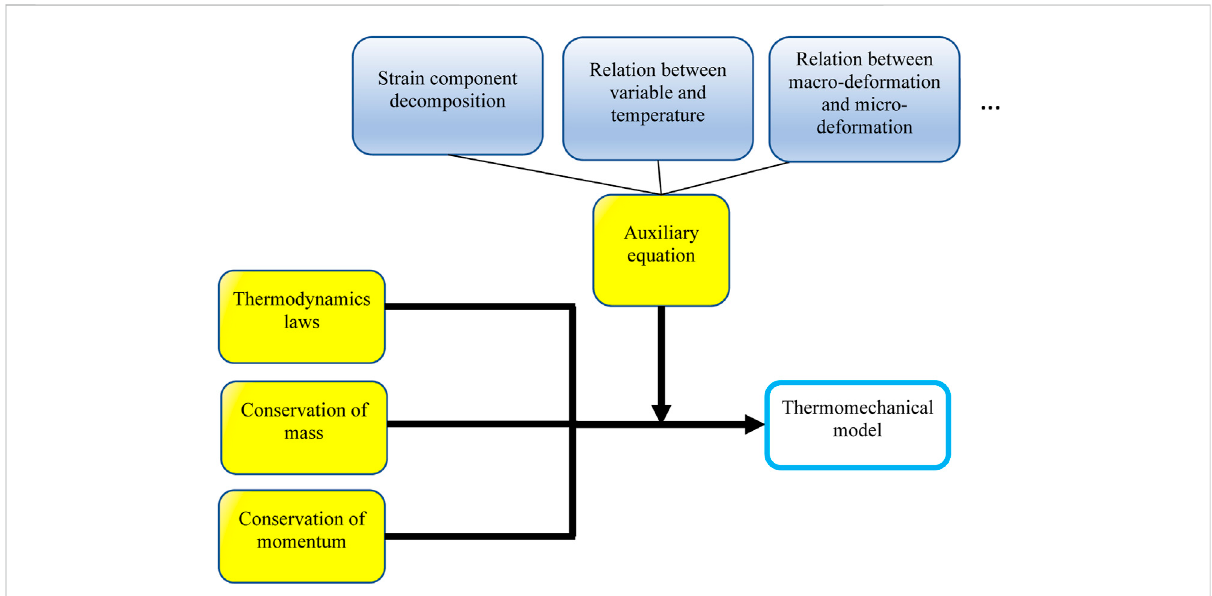
FIGURE 10 Flowchartofthegeneralthermomechanical modelforSMPs[Reproducedwithpermission fromJournalofApplied Physics, 131:111101,(2022). Copyright 2022 American Institute of